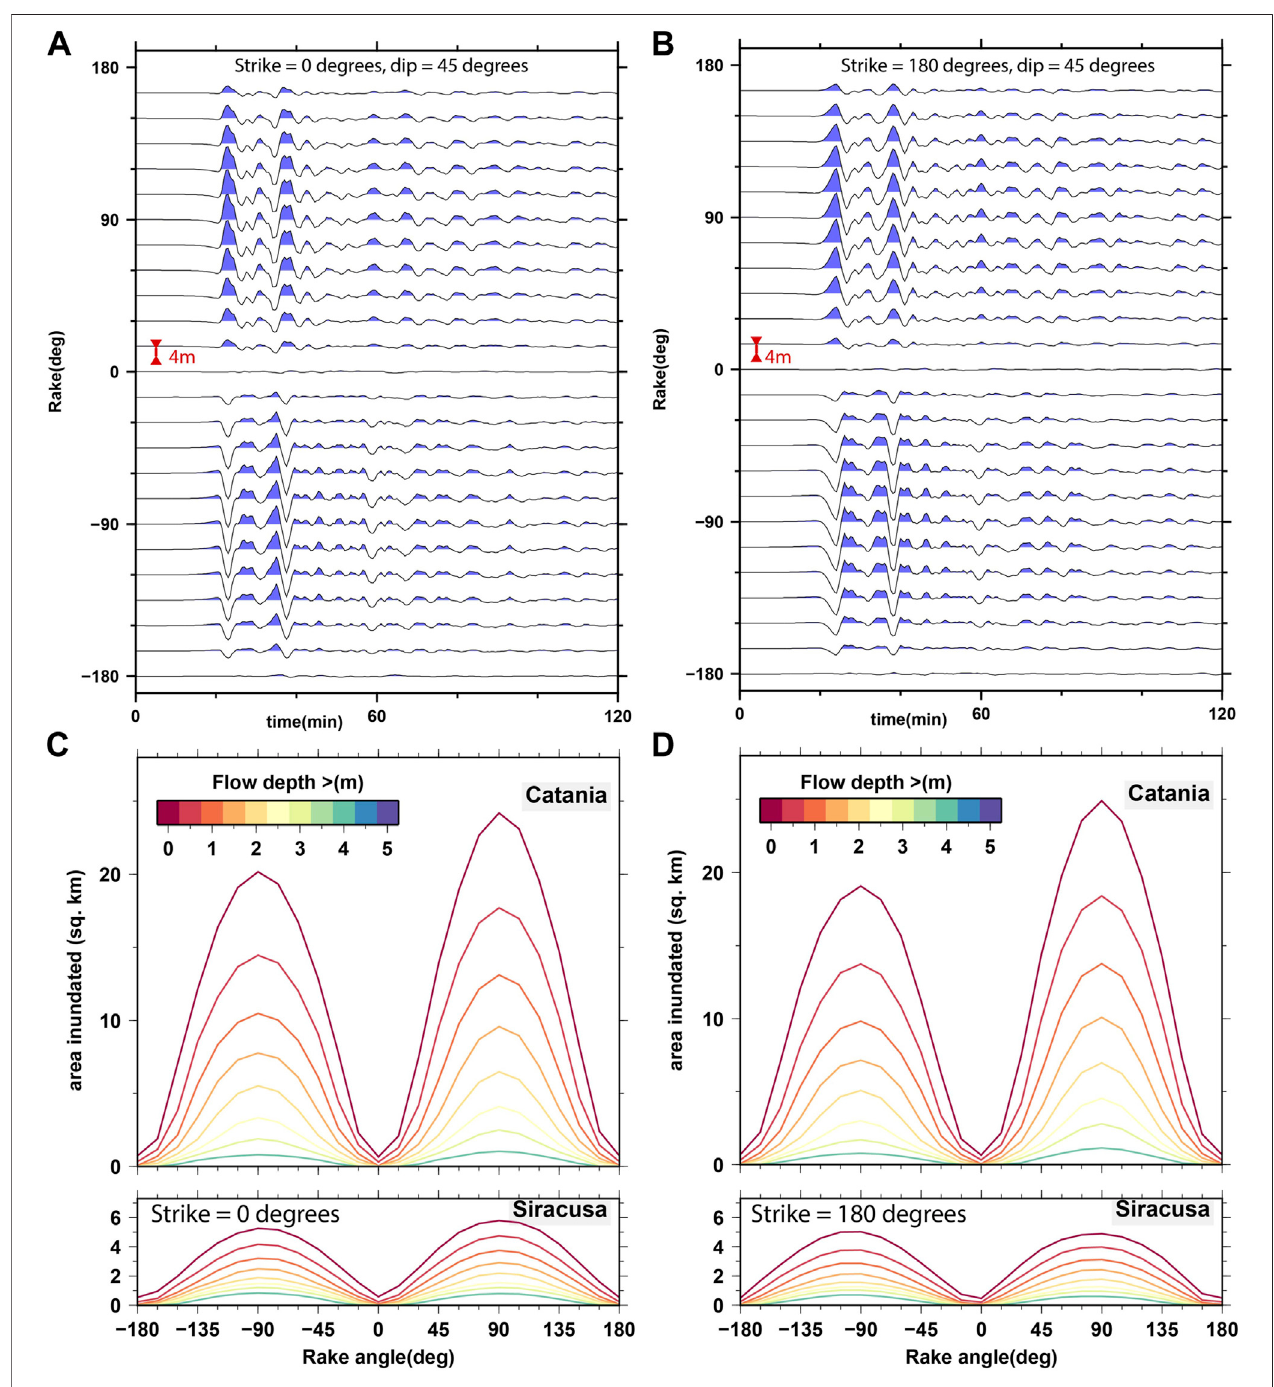
FIGURE7| Varying theangle ofrake. (A,B) Offshoresurfaceelevation time-series generated bytheTsunami-HySEAcodeforthelocation37.5368 o N,15.1333 o E, offshoreoftheBayofCataniaonSicilyasafunctionofminutesaftertheearthquakeorigintime.Allchannelsaredisplayedtothesameverticalscalewiththeredscalebar indicating a vertical displacement of 4 m (C,D) Area of land inundated with a fl ow depth exceeding the value indicated by the colour for the tsunamis generated by the earthquakes in the scenarios as indicated. The areas measured for Catania are within the region displayed in Figure 1C and the areas measured for Siracusa are within the region displayed in Figure 1D . The curves are displayed for the following values of the height, h: 0.01, 0.5, 1.0, 1.5, 2.0, 2.5, 3.0, and 4.0 m.